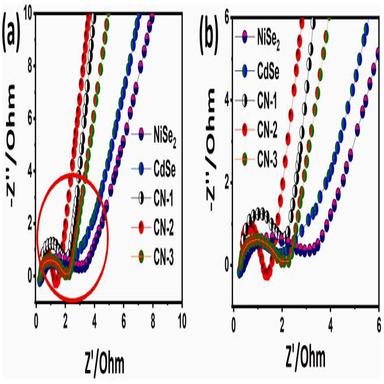
(a) The impedance plot of the electrodes, (b) the enlarged view of the encircled region.